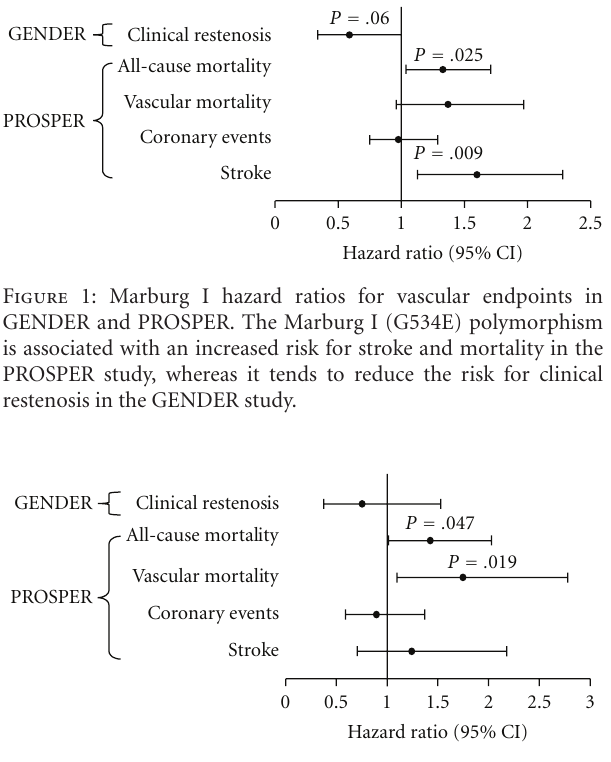
II polymorphism, there were only 234 heterozygotes and